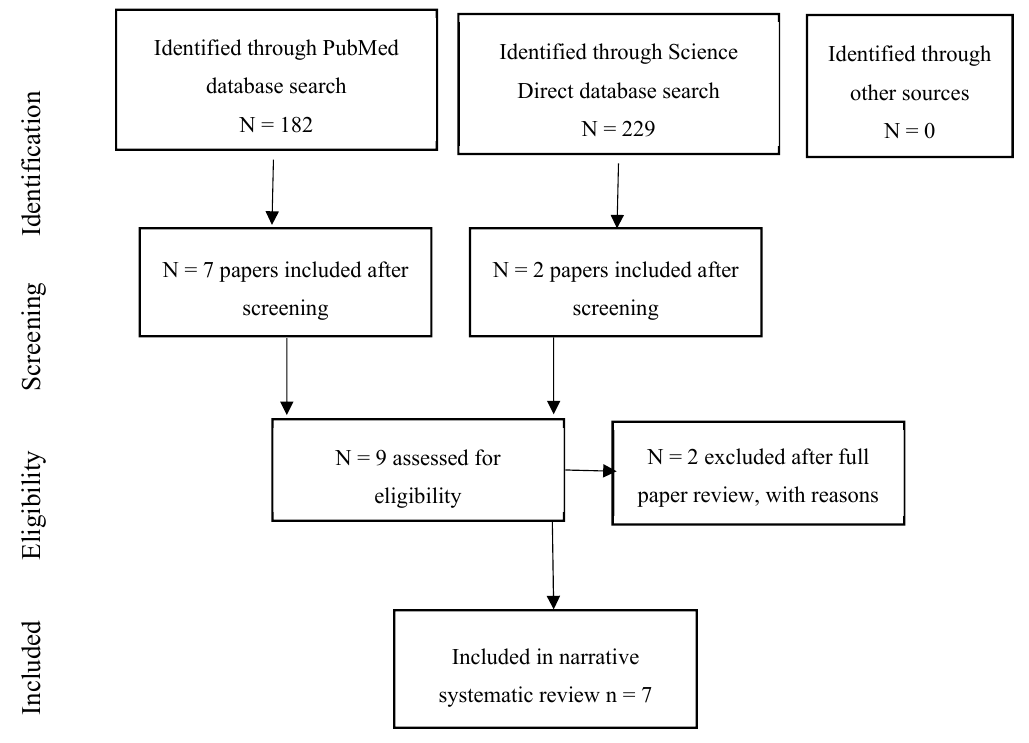
Figure 3. Flow chart showing the review process for the dementia papers. Table 9. Summary of the strength of the evidence for dementia and other neurodegenerative outcomes Dementia and Other Neurodegenerative